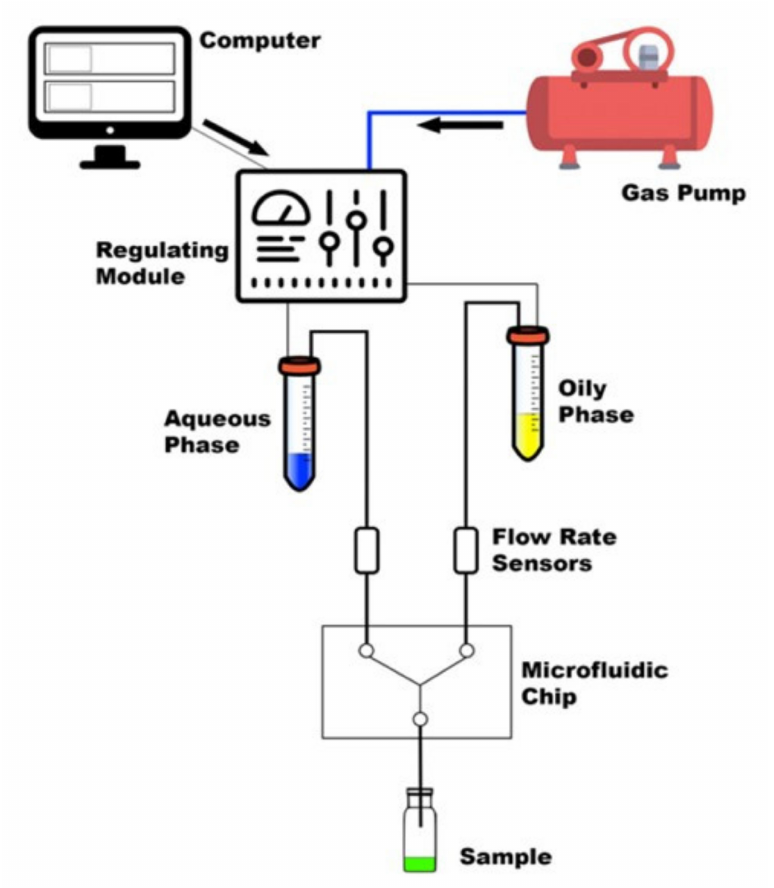
Figure 2. Summary of the main components of MF system